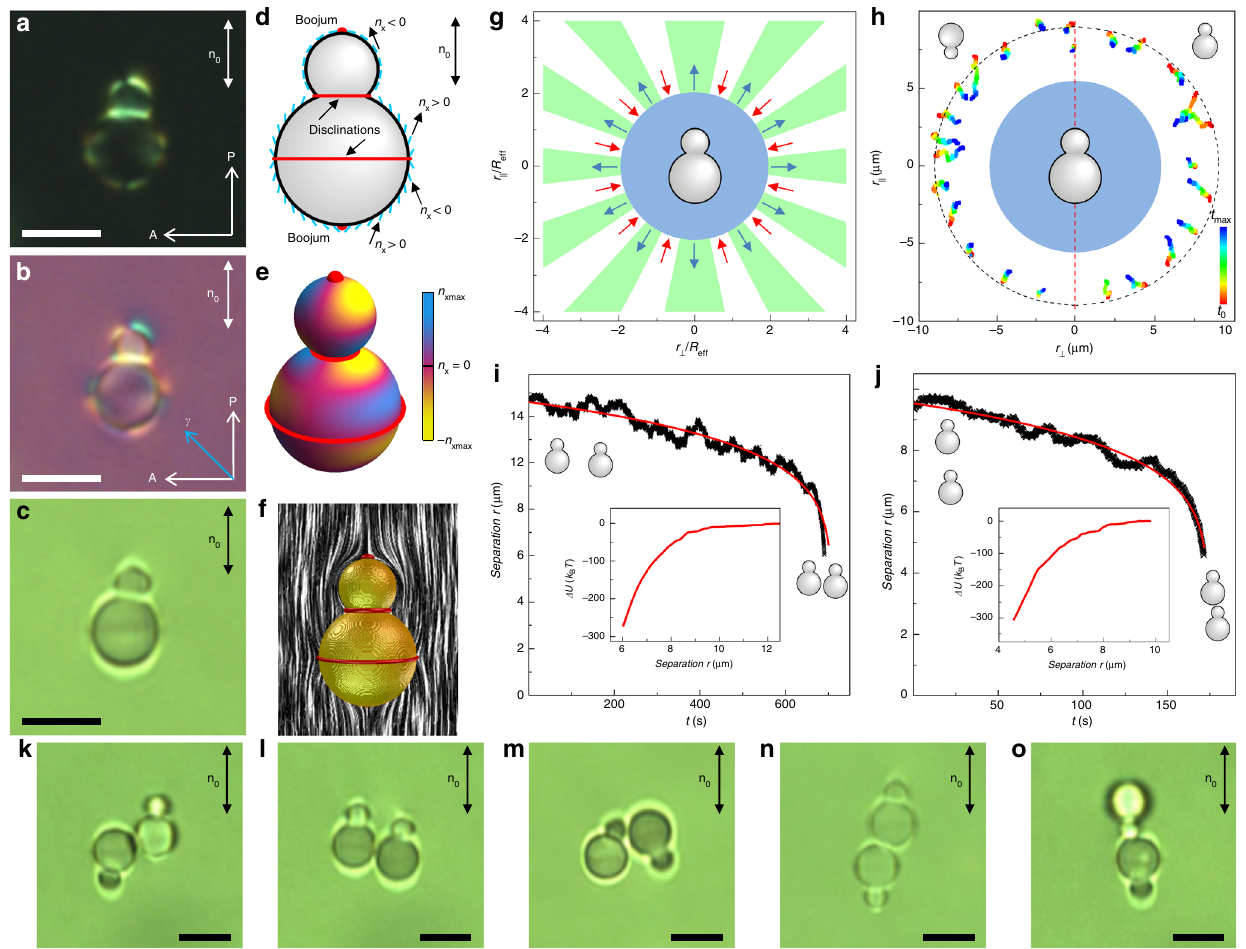
Fig. 3 Elastic multipole induced by a gourd-shaped particle. a – c Textures of a sample with a gourd-like particle in a nematic cell from optical polarizing, a without and b with a retardation plate, and c bright fi eld microscopy. d , e Schematic diagram (blue lines) of n ( r ) at the surface and corresponding color- coded diagram of n x . f Calculated n ( r ). g , h Map of elastic interactions between gourd particles with respect to n 0 calculated for elastic 64-poles with ( g ) only 64-pole non-zero coef fi cient and ( h ) experimentally measured. Dashed red line in ( h ) separates maps of interactions for parallel and antiparallel particles. i , j Separation vs. time dependence for gourd particles elastically interacting along the direction approximately ( i ) perpendicular and ( j ) parallel to n 0 . Insets show the corresponding dependence of the interaction potential from the distance between particles with a 64-pole coef fi cient b 6 ≈ − 3 × 10 − 5 extracted from fi tting. k – o Textures of self-assembled pairs of the gourd-shaped particles imaged by bright- fi eld microscopy. Scale bar: 5 μ